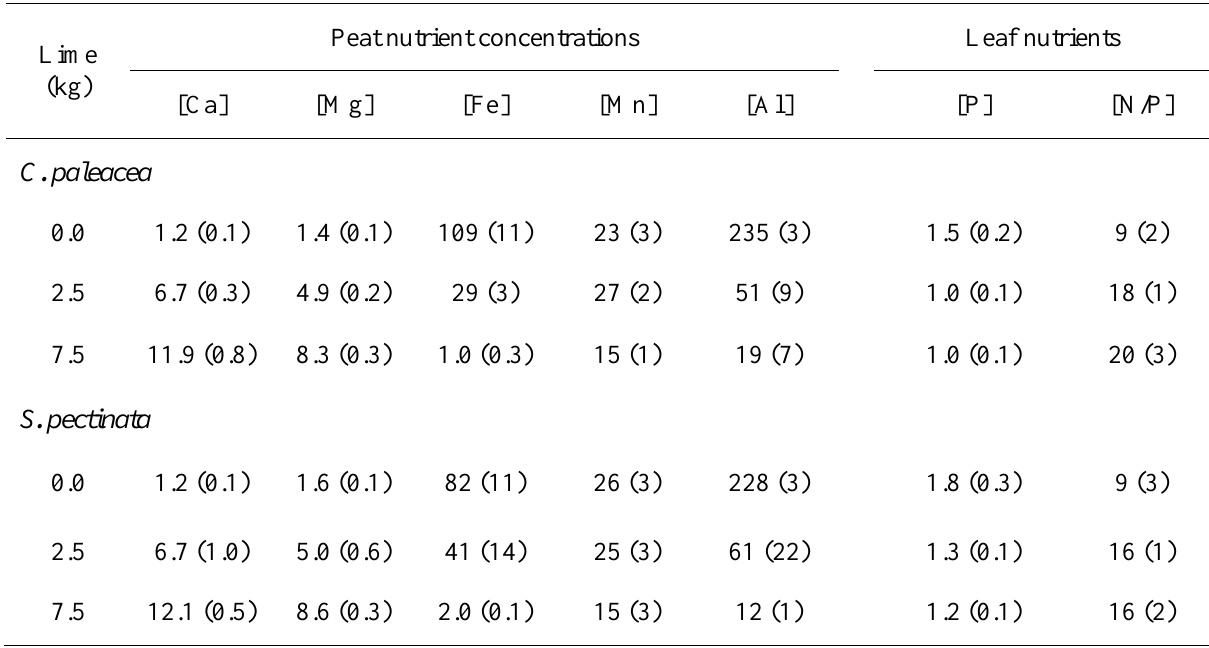
Table 3. The effects of lime additions on peat (soil exchangeable) and leaf nutrient concentrations in C. paleacea and S. pectinata plots in the greenhouse experiment. Only variables for which there were significant differences are presented. Mean ( n = 9) concentrations and (SE) are given in mg g -1 for Ca, Mg and P or in µg g -1 for Fe, Mn and